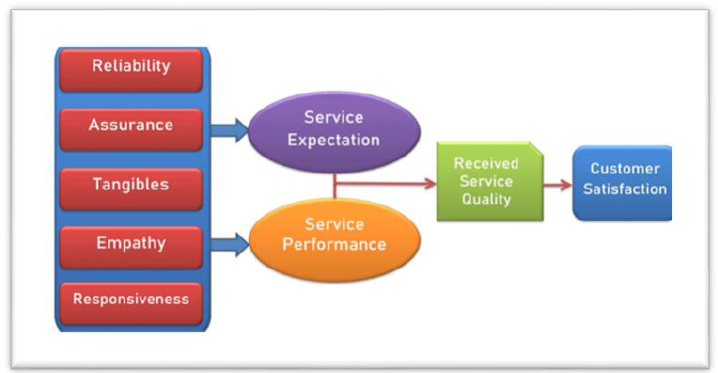
Figure 1: Servqual Model; Source: Johnson and Karlay, 2018